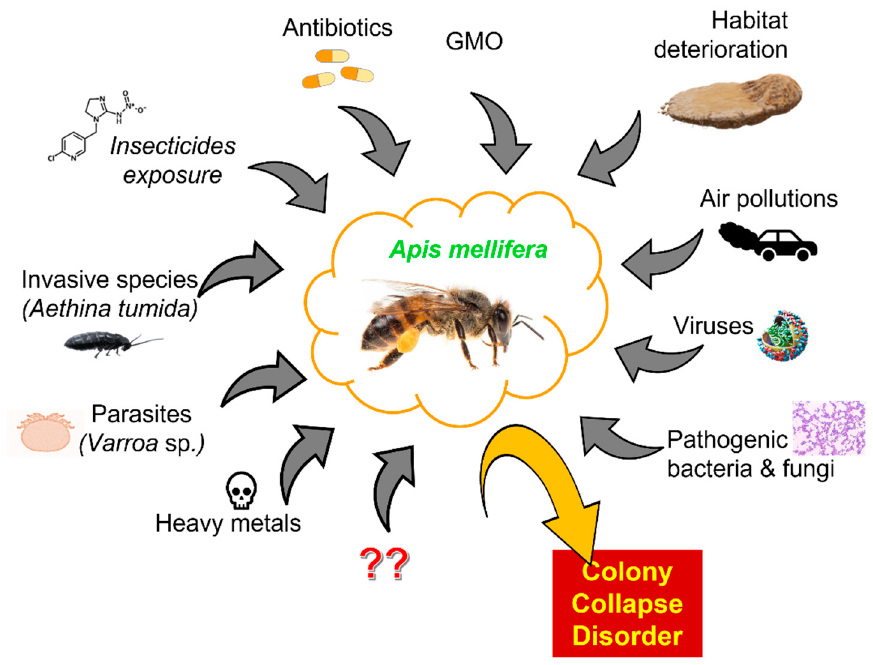
Figure 1. Factors contributing to CCD of A. mellifera .